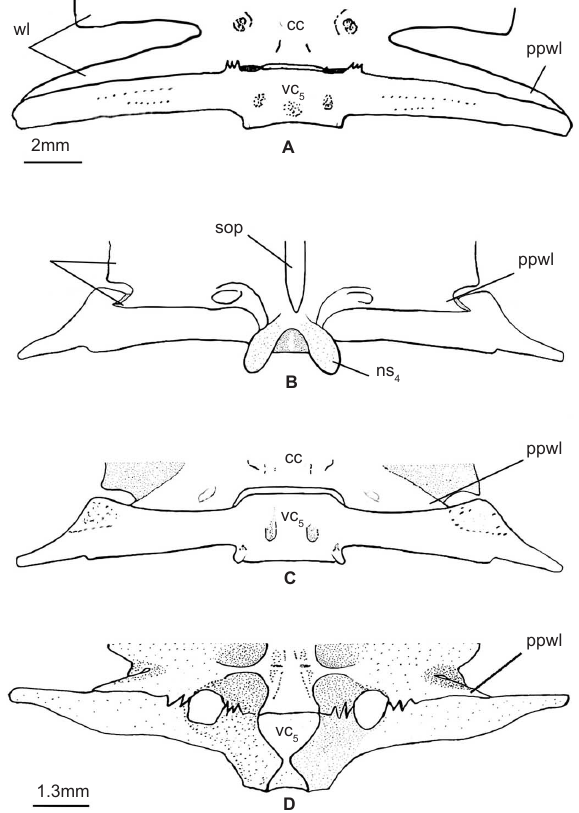
Figure 3. Weberian lamina: A - ventral view of G. chindwinica (MUMF 9997); B - dorsal, C - ventral of G. ngapang (MUMF 6141); D - ventral view of G. botius (unscale) (MUMF 9520). wl - Weberian lamina, ppwl-posterior portion of Weberian lamina; cc - complex centrum; vc5 - fifth vertebral centrum; ns4 - fourth neural spine; sop - spine of